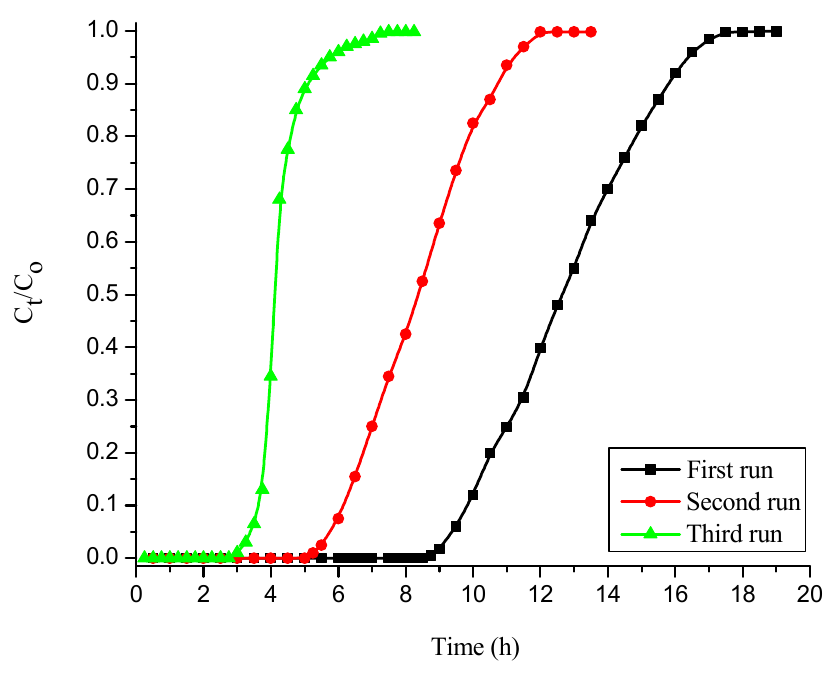
Figure 4. Breakthrough curves (BTCs) for decolorization of CR dye onto free NNLP adsorbent in various runs. (Initial pH: 6; flow rate: 1 mL min − 1 ; inlet dye concentration: 15 mg L − 1 ; temperature: